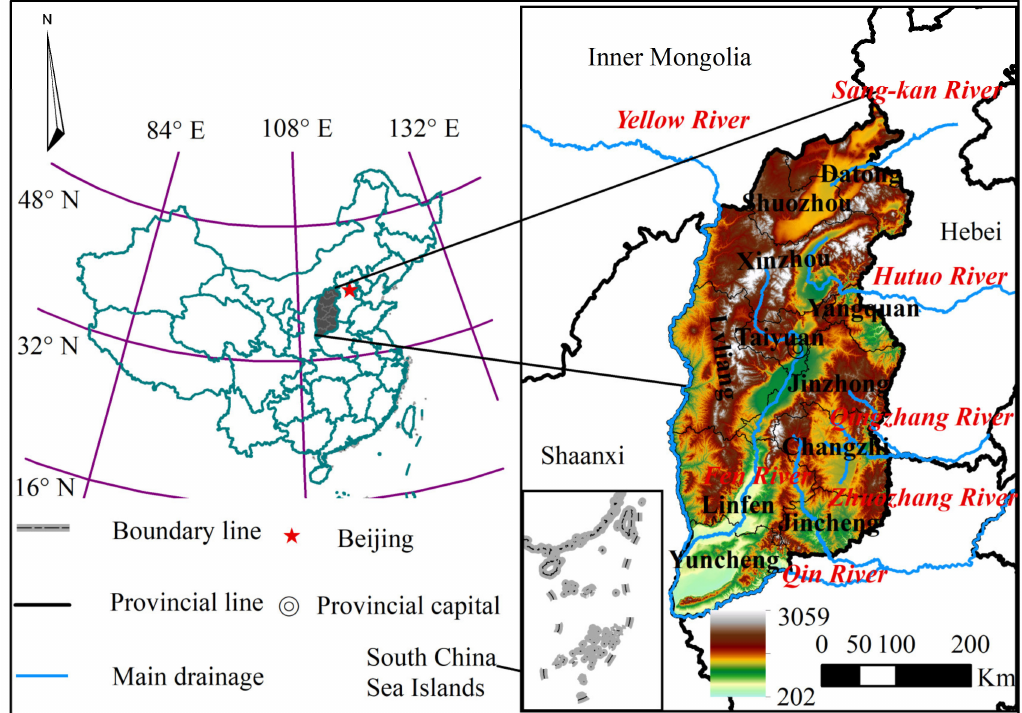
Figure 1. Schematic map of the study